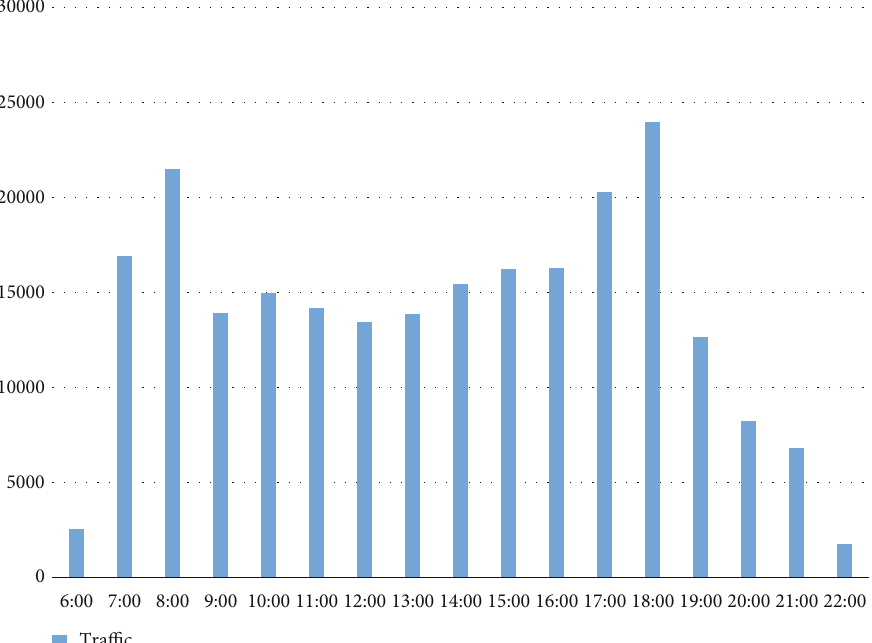
Figure 9: Distribution of incoming passengers at di ff erent times on working